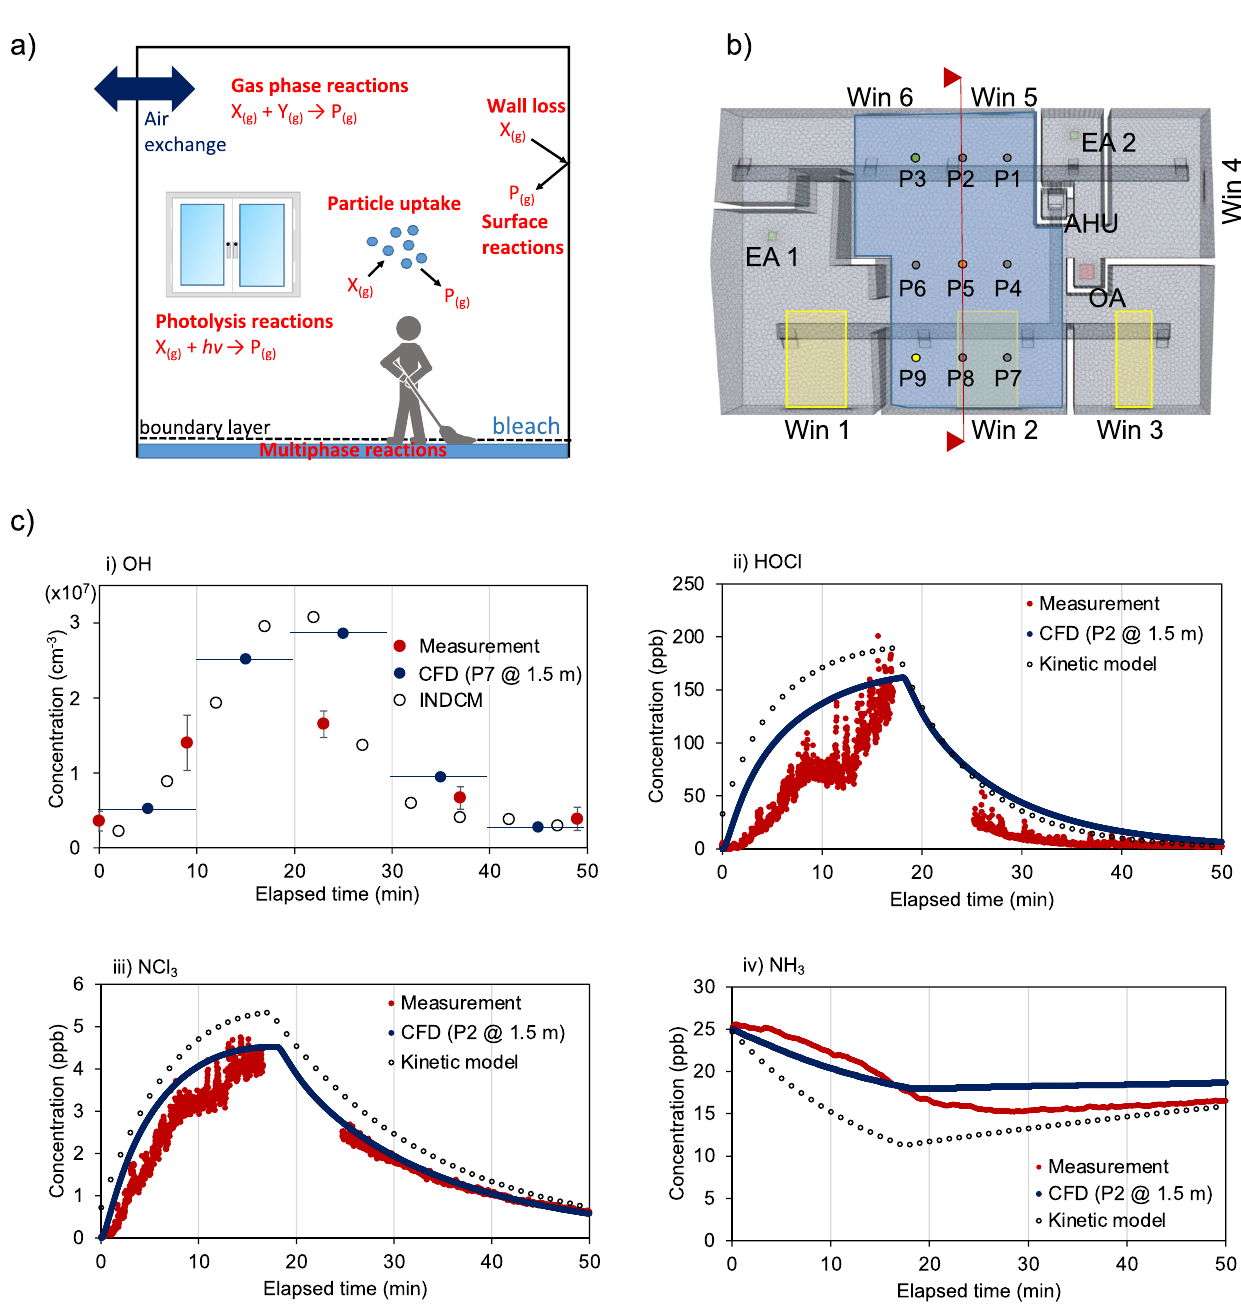
Fig. 1 Integrated modeling of bleach cleaning events. a A schematic of the kinetic model to simulate a cleaning event at the HOMEChem campaign. b The fl oor plan of the test house and computational fl uid dynamics modeling geometry (Win: window, AHU: air handling unit, EA: exhaust air, OA: outside air). The yellow marks are solar radiation zones and blue marks are cleaning area. Nine points (P1 – P9) at 1.5 m above the cleaning fl oor surface are the calculation points in CFD simulations. The vertical red line represents the cross-section used for the vertical maps presented in Fig. 2. c Temporal evolution of (i) OH, (ii) HOCl, (iii) NCl 3 , and (iv) NH 3 as measured (red) and simulated by the CFD (dark blue), the INDCM (open markers in c (i)), and the multiphase kinetic model (open markers in c (ii – iv)). The error bars in ( c ) represent the 1 σ precision of the OH measurements and are separate from the calibration accuracy (±18%, 1 σ